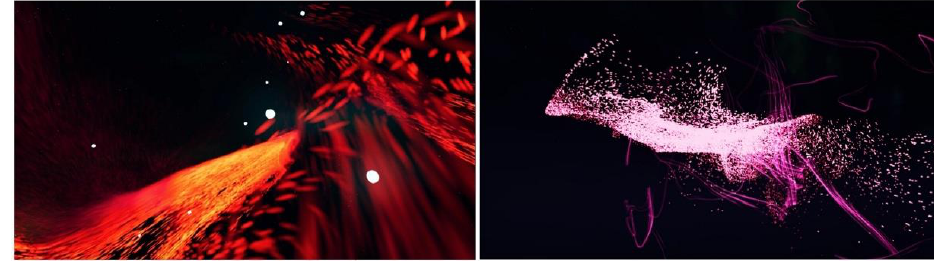
Figure 1. Two screenshots from the Binaural Odyssey application.